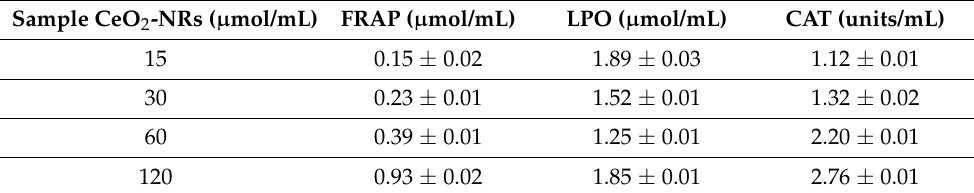
Table 1. FRAP, LPO, and CAT assay for the human lymphocytes incubated with CeO 2 -NRs.